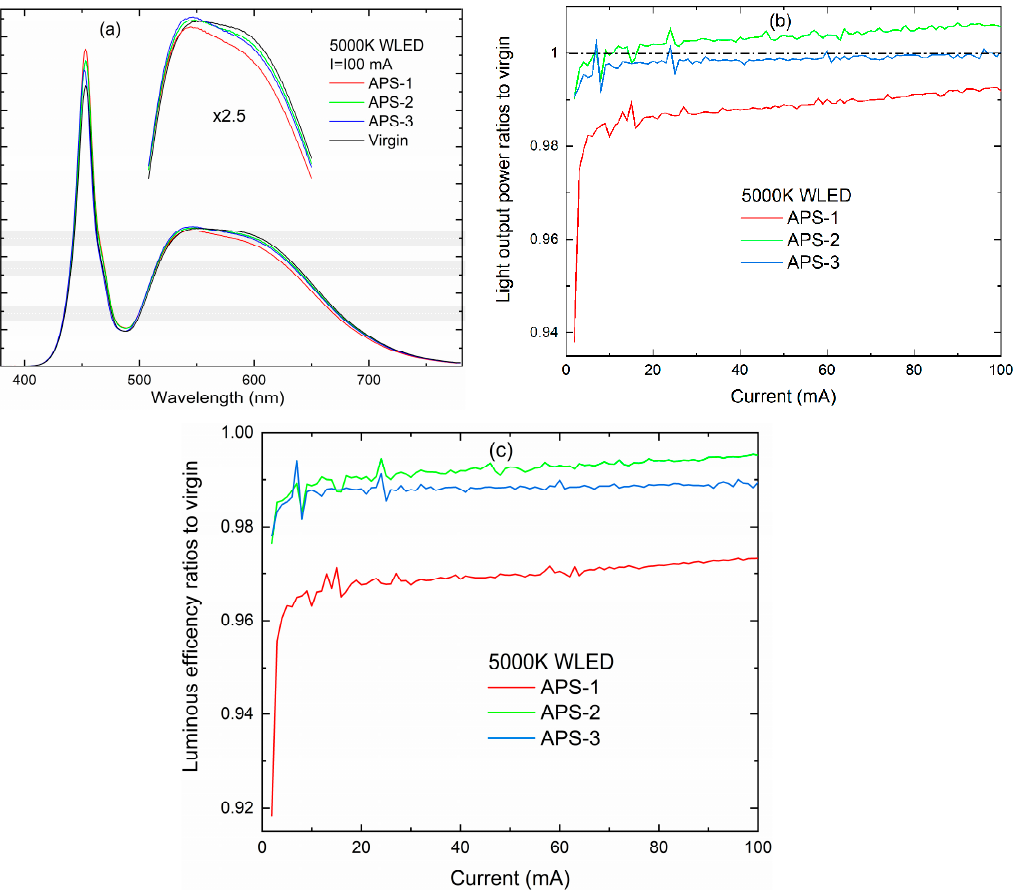
Figure 2. EL results of white LEDs of 5000 K mounted with and without APSs. ( a ) EL spectra at current of 100 mA. Current dependencies of ( b ) light output power ratios to virgin and ( c ) luminous efficiency ratios to virgin for different APSs. The periods of the APSs are about 450 nm. In the inset of ( a ), four magnified segments are shown as 2.5 times of those in the original ones.